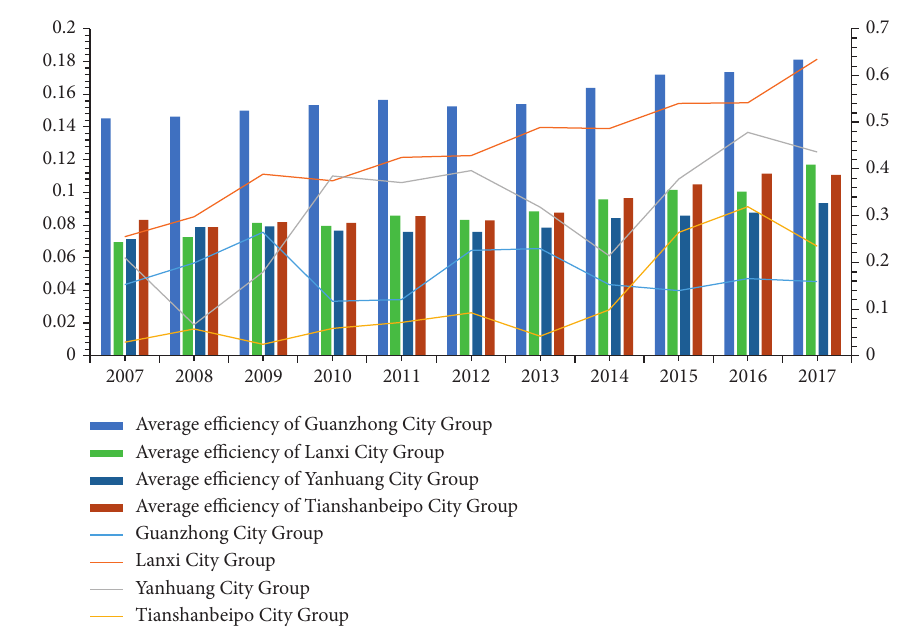
Figure 8: Average green development efficiency and convergence coefficient of northwest urban agglomeration,